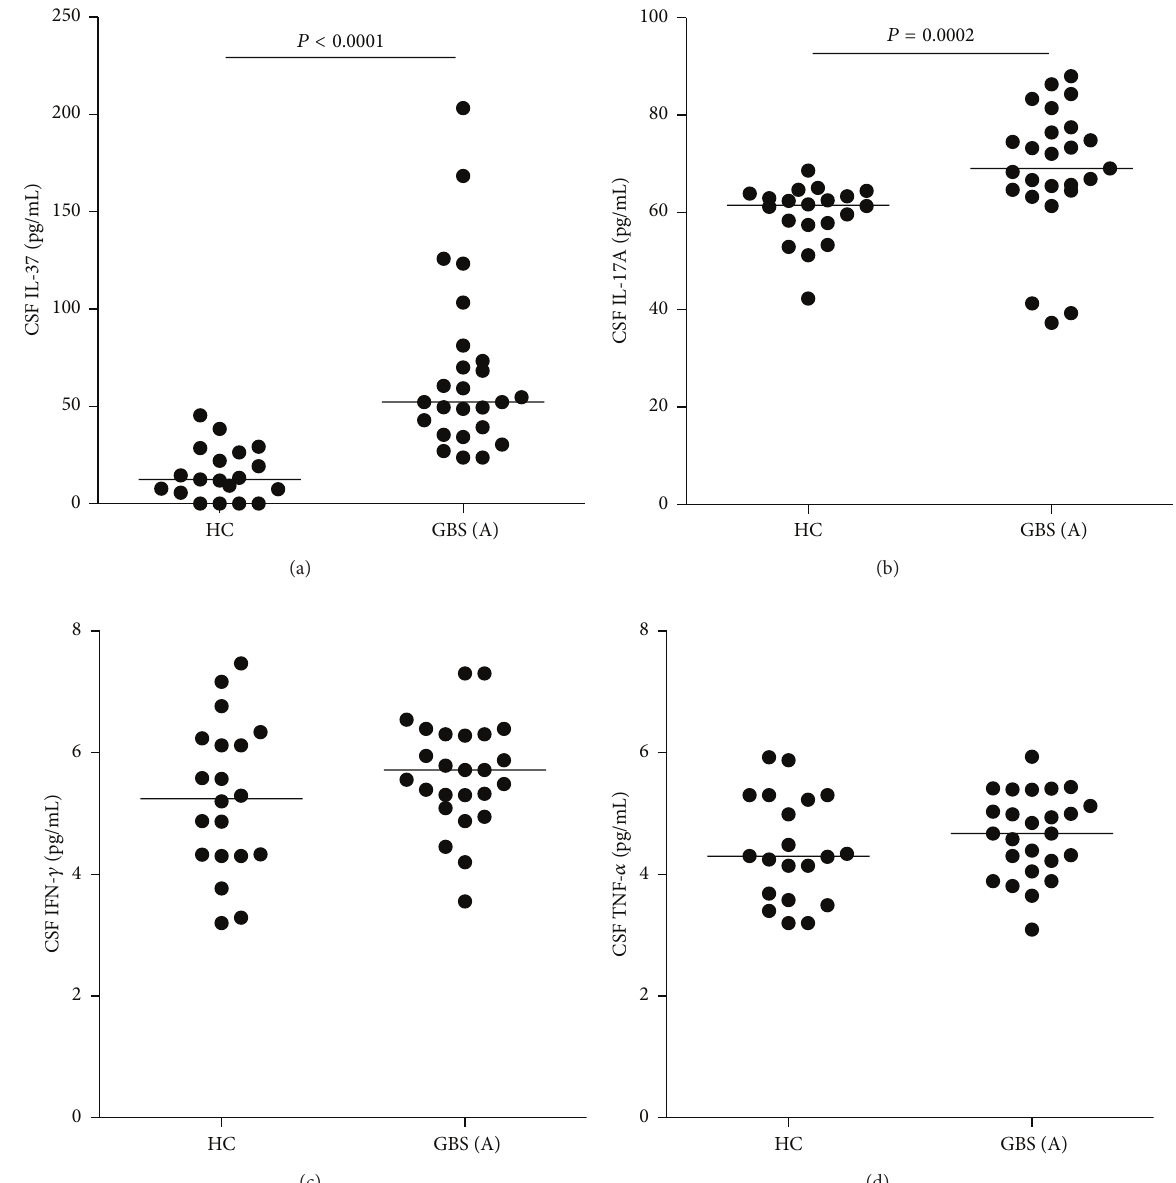
Figure 2: The concentrations of CSF cytokines. The concentrations of CFS IL-37 (a), IL-17A (b), IFN- 𝛾 (c), and TNF- 𝛼 (d) in individual patients with new onset GBS ( 𝑛 = 25 ) and the HC ( 𝑛 = 20 ) were determined by ELISA and CBA, respectively. Data shown are the mean values of individual subjects from three separate experiment, and the horizontal lines indicate the median values of individual